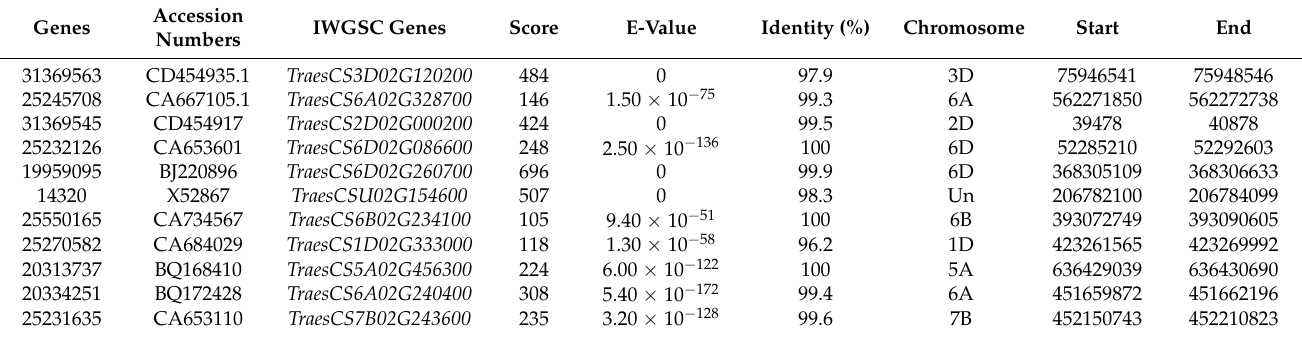
Table 2. Gene ID conversion provided the information about SDGs in the form of columns. First and second columns are the IDs that resulted from differential expression analyses. Similarly, third column was filled with their respective IWGSC IDs due to their high numbers in the form of alignment scores and residual identity in percentages with low E-values. Genomic locations were recorded by searching ENSEMBL database and provided as last three